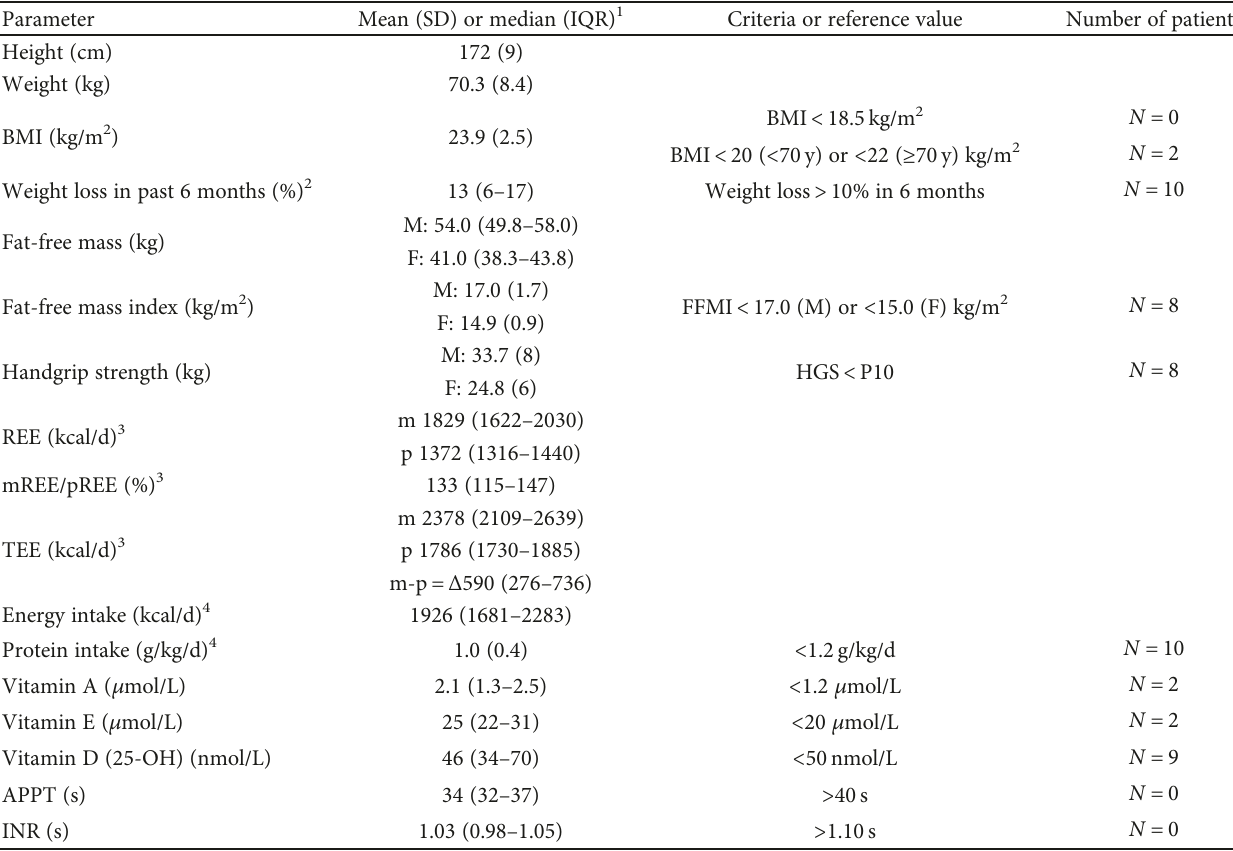
Table 2: Results of the parameters of the nutritional assessment.